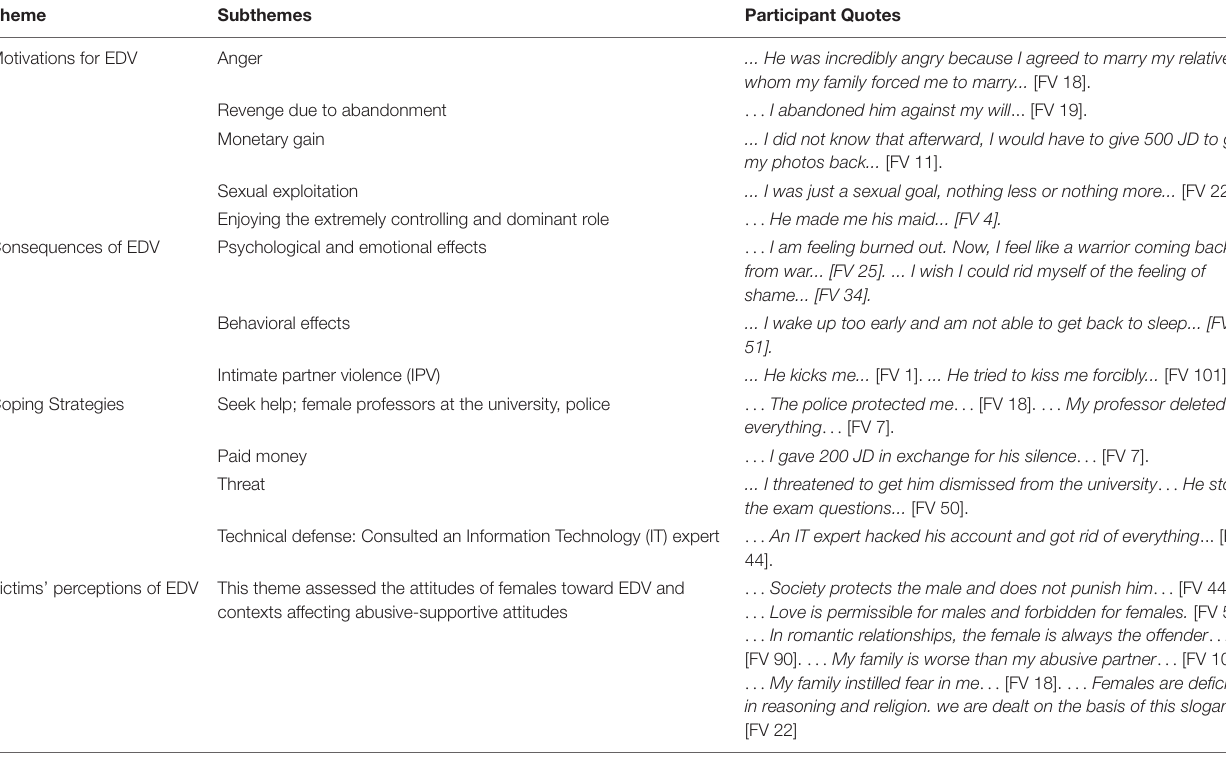
TABLE 1 | Summary of the